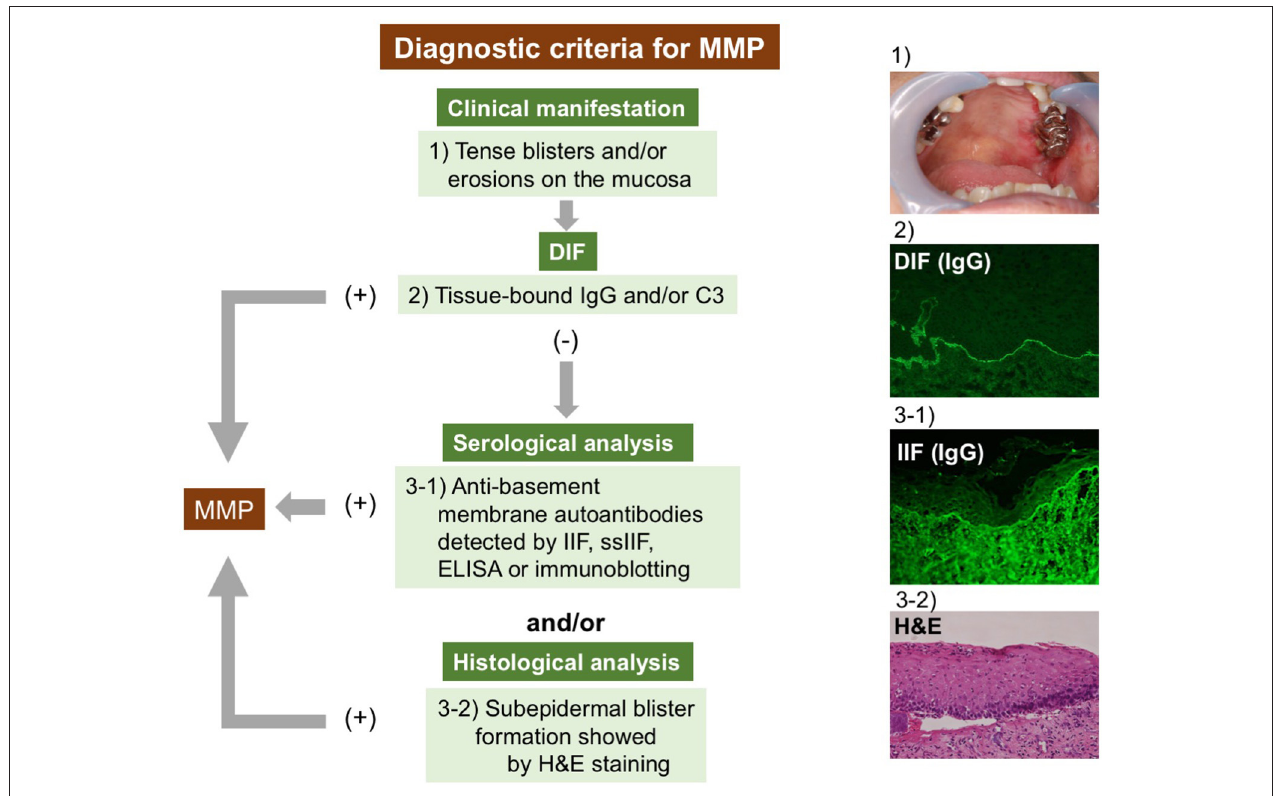
FIGURE 1 | Diagnostic strategy for MMP. The diagnosis of MMP is confirmed by clinical features and positive DIF results. In DIF-negative or DIF-unavailable cases, at least one serological or histological finding is needed. DIF, direct immunofluorescence; IIF, indirect immunofluorescence; ELISA, enzyme-linked immunosorbent assay; H&E, hematoxylin and eosin